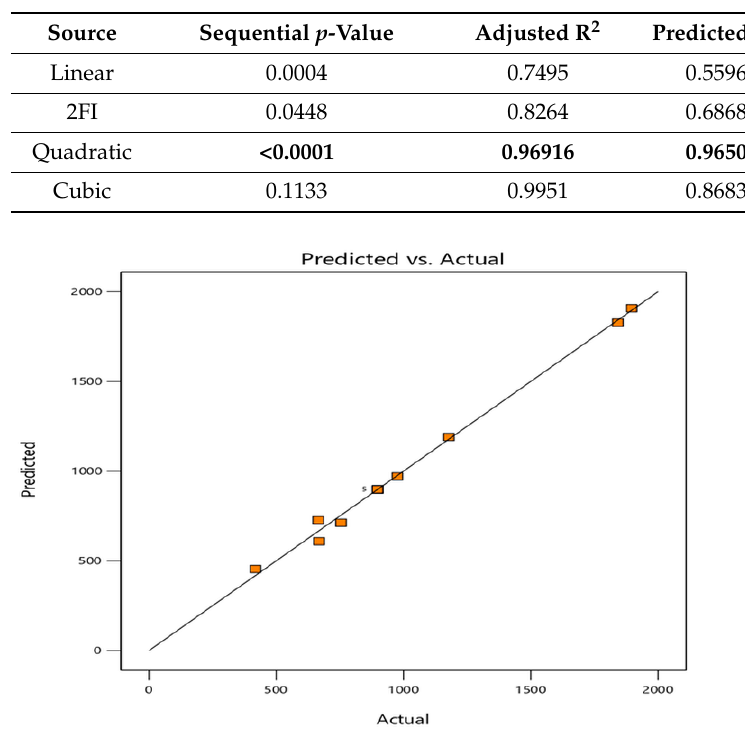
Table 2. Power response fit summary for different models.